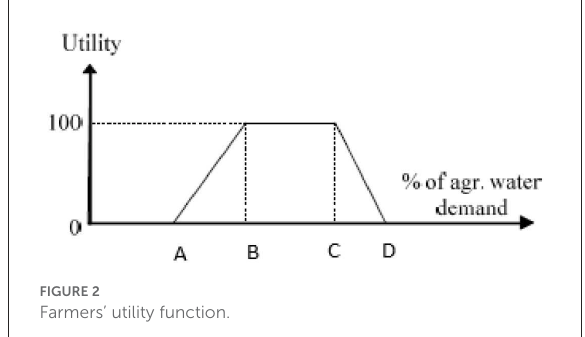
FIGURE2 Farmers’ utility